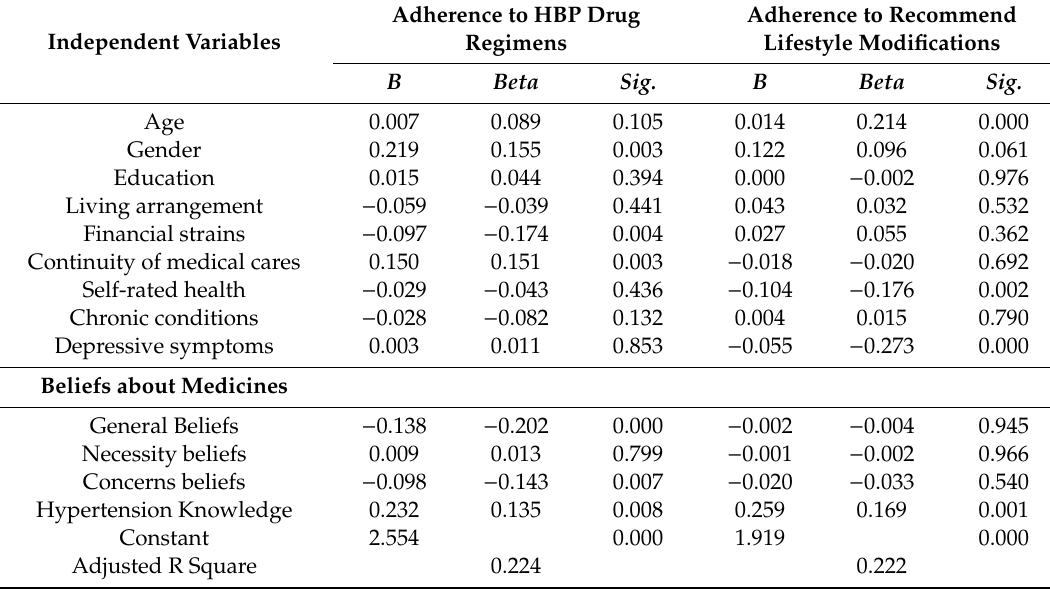
Table 3. Multiple linear regression between explanatory variables and blood pressure self-care scale among underserved middle-aged and older African American adults ( n =